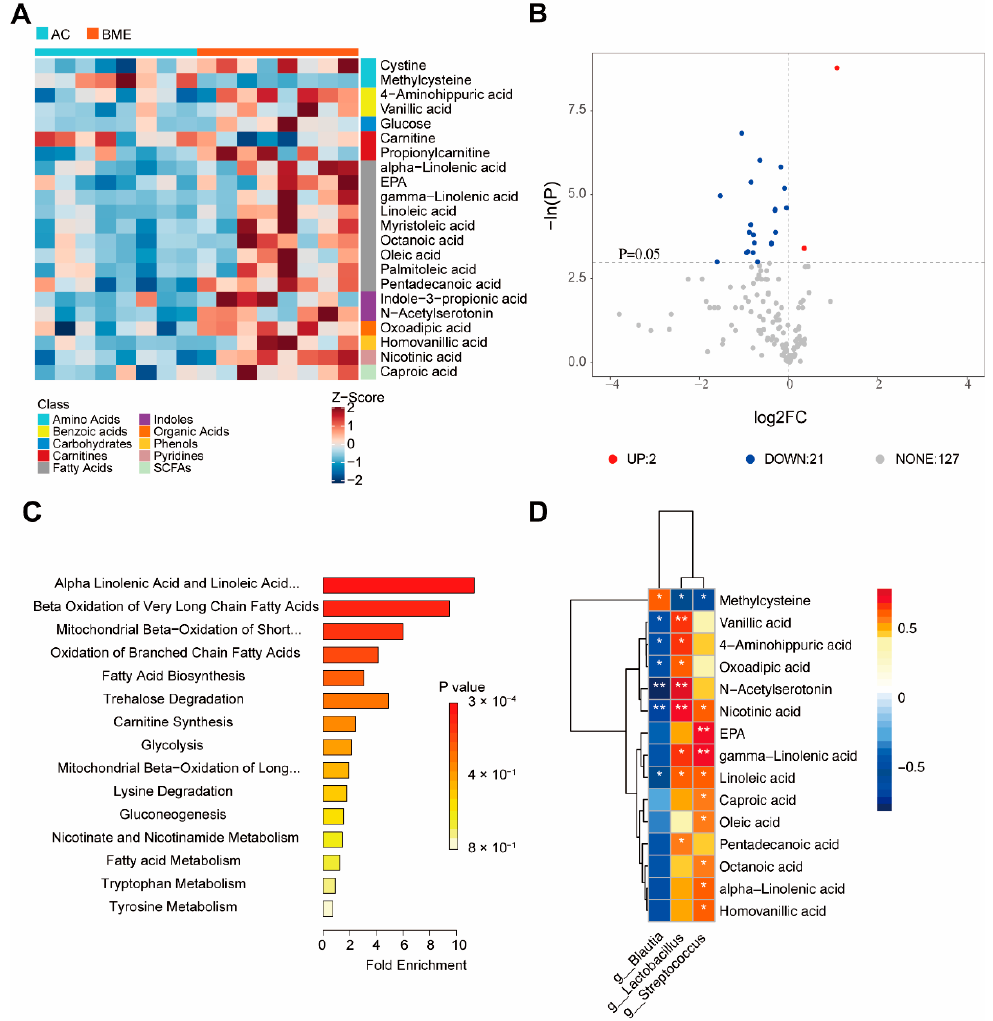
Figure 7. Effects of BME on metabolites of intestinal microbiota of mice were detected by targeted metabolomic profiling. ( A ) A heat map of intestinal metabolite levels. ( B ) A volcanic map of intestinal metabolite levels. ( C ) Differential metabolite enrichment analysis. ( D ) A correlation heat map between concentrations of differential metabolites and intestinal microbiota. All results are expressed as means ± SEMs ( n = 8). * p < 0.05 versus AC group, ** p < 0.01 versus AC group. AC: aged control, BME: blueberry–mulberry extract.